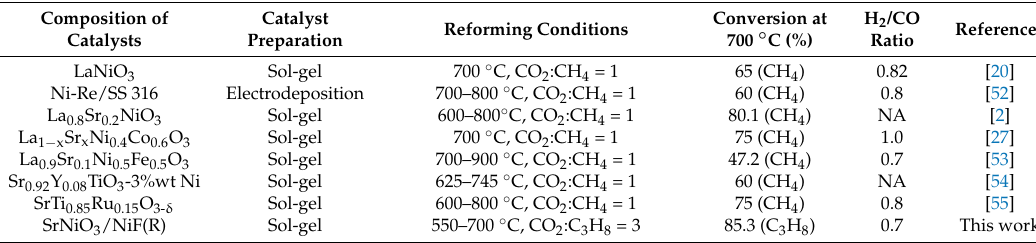
Table 3. Performance of the perovskite catalysts in dry reforming of